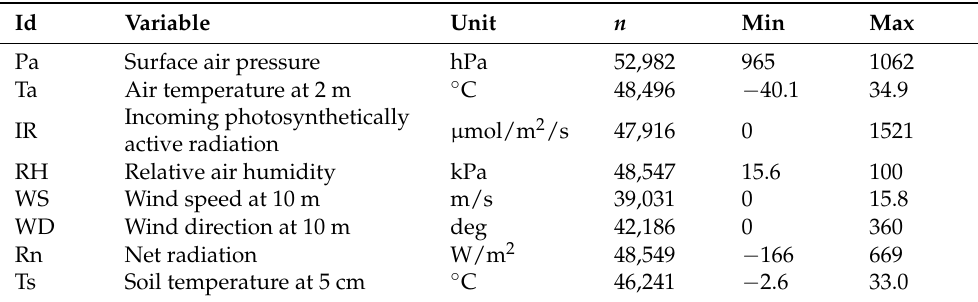
Table 1. List of meteorological variables from the automated weather station, minimal and maximal observed values, n —number of available records.